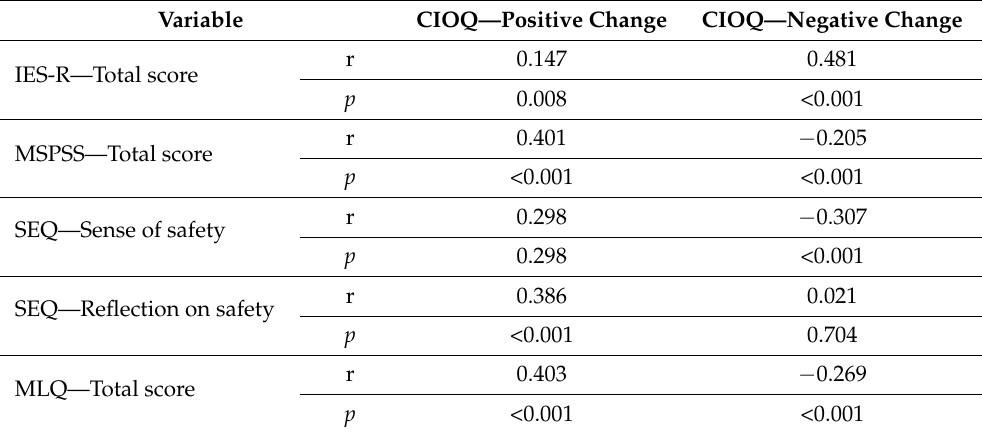
Table 3. The relationship between the CIOQ subscales and selected cognitive variables. Variable CIOQ—Positive Change CIOQ—Negative